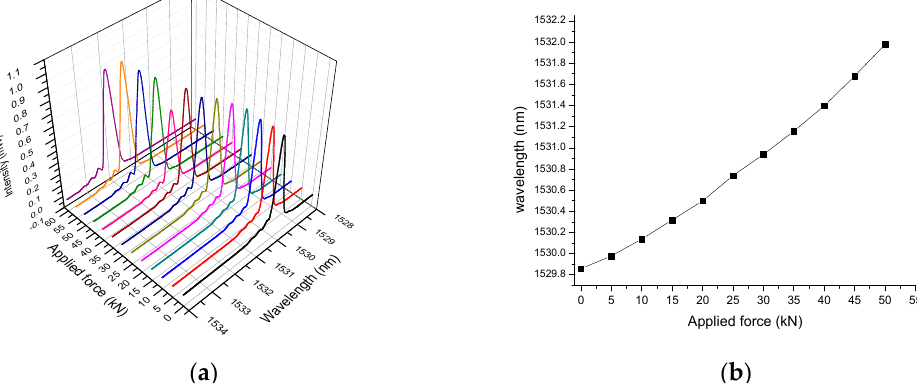
Figure 8. ( a ) 2 mm FBG spectral response with applied force in the composite patch, near the crack-tip. ( b ) Peak spectral response with applied force.